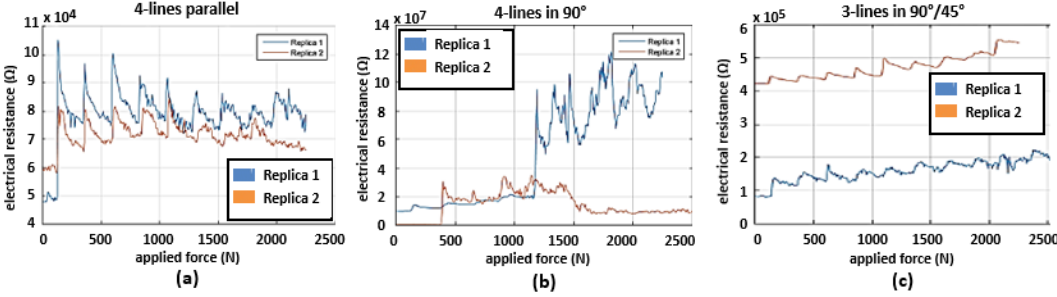
Figure 22. Compression tests. Electrical resistance vs applied force for three manufactured MRE transducers shown in Figure 3. Two tests (Replicas 1 and 2) were carried out for each transducer. ( a ) Four lines in parallel; ( b ) four lines in 90 ◦ ; and ( c ) three lines in 90 ◦ /45 ◦